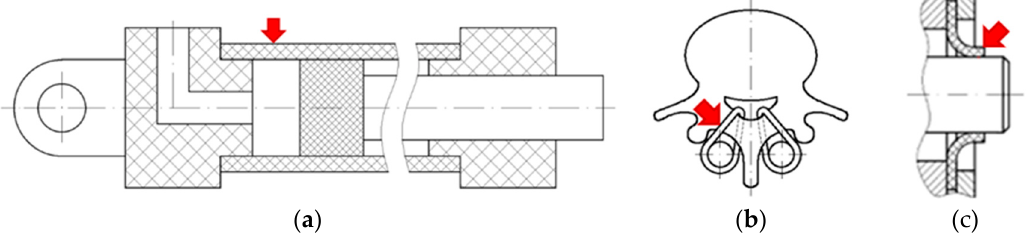
Figure 1. Deformed parts (indicated by red arrows) made of polymeric materials interacting frictionally: ( a ) hydraulic cylinder tube; ( b ) spine stabilising wires; and ( c ) shaft lip seal.